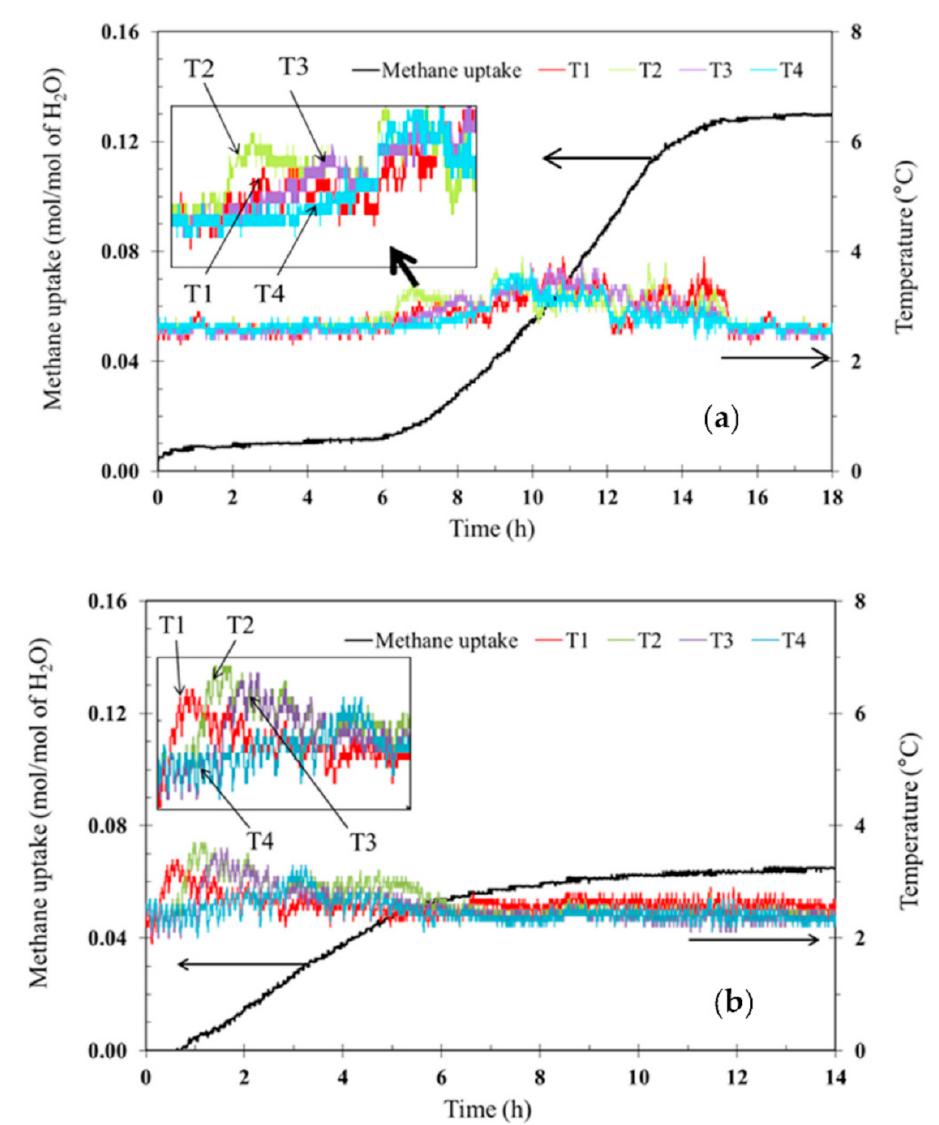
Figure 5. Methane uptake and temperature profiles during the methane hydrate formation experiment performed with the TBAB solution at 2.5 ◦ C: ( a ) w = 0.05 (Experiment 4, Table 1), ( b ) w = 0.10 (Experiment 9, Table